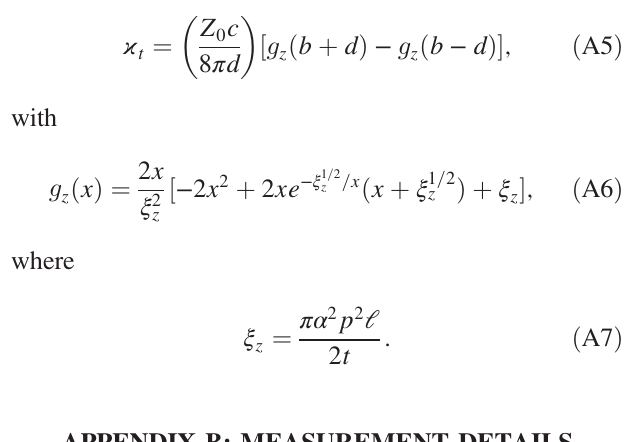
FIG. 10. The measured variation in average offset para- meter, δ b , corresponding to tilt parameter d i measurements. The abscissas were shifted by the fitted d 0 , to be consistent with the main measurement plots, Figs. 7 and 8